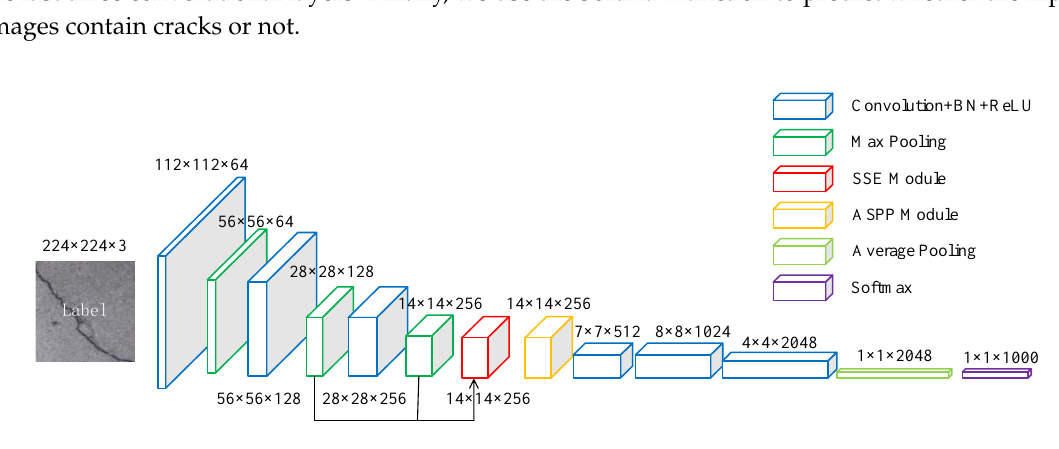
Figure 2. Illustration of the crack detection network, SSENets.